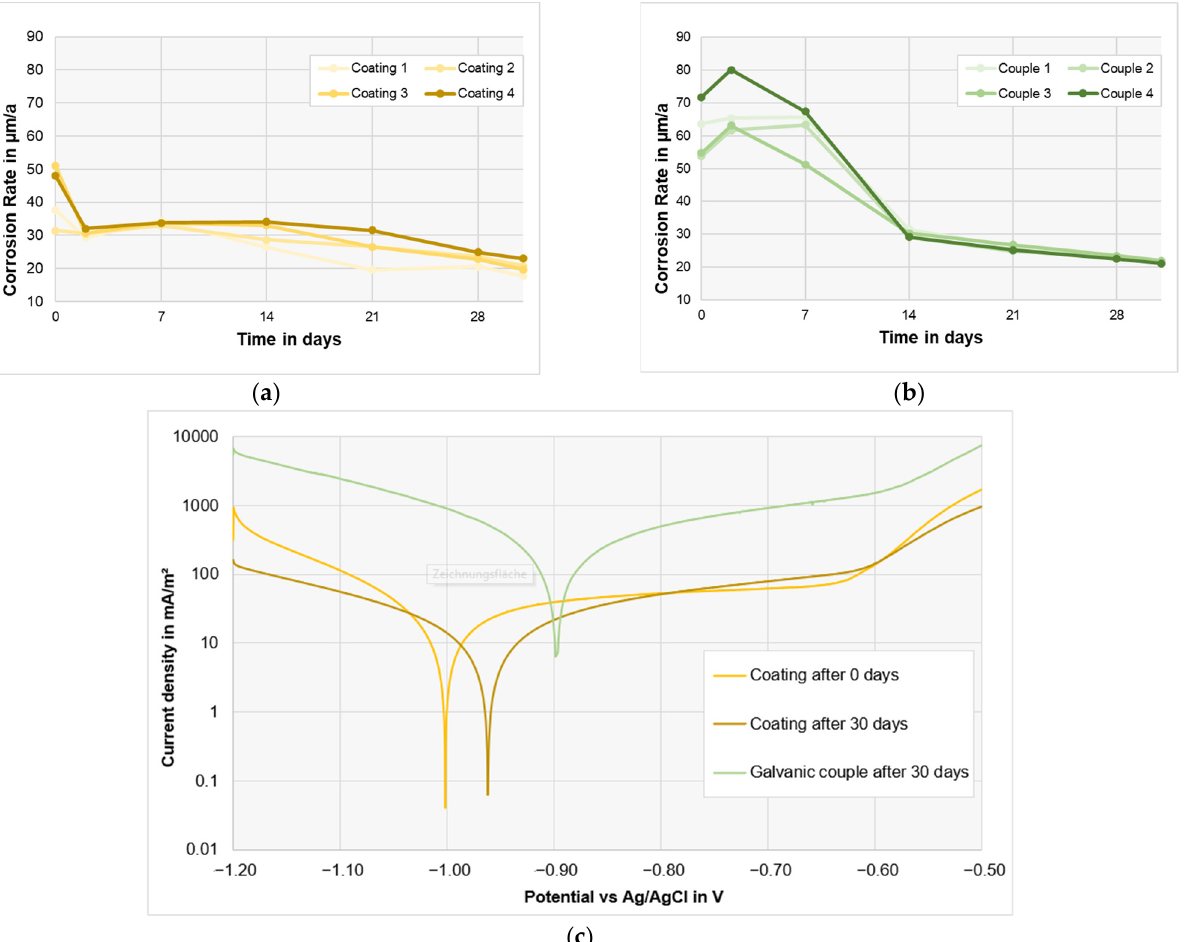
Figure 15. ( a ) The corrosion rate of the thermal spray coating; ( b ) The corrosion rate of the galvanic couples; ( c ) Potentiodynamic polarization curves of the coating at the start of the test, and of the coating and a galvanic couple after 30 days.